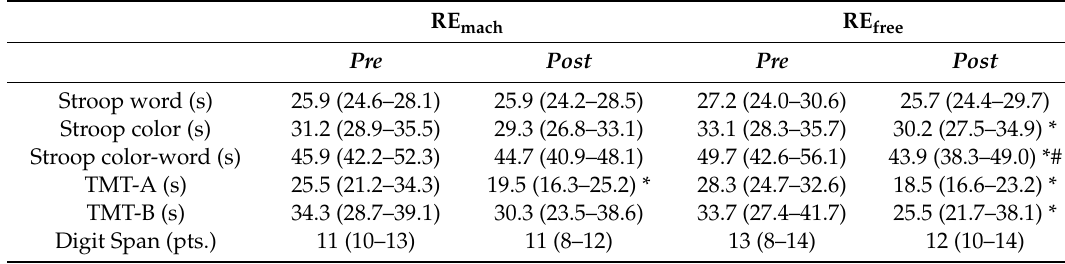
Table 2. Cognitive performance measured pre- and post-intervention in both groups. RE